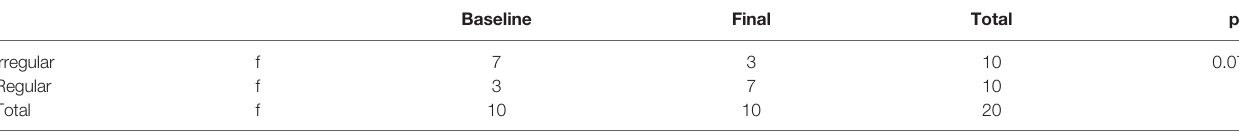
TABLE 5 | Changes in the menstrual cycle. Baseline Final Total p f